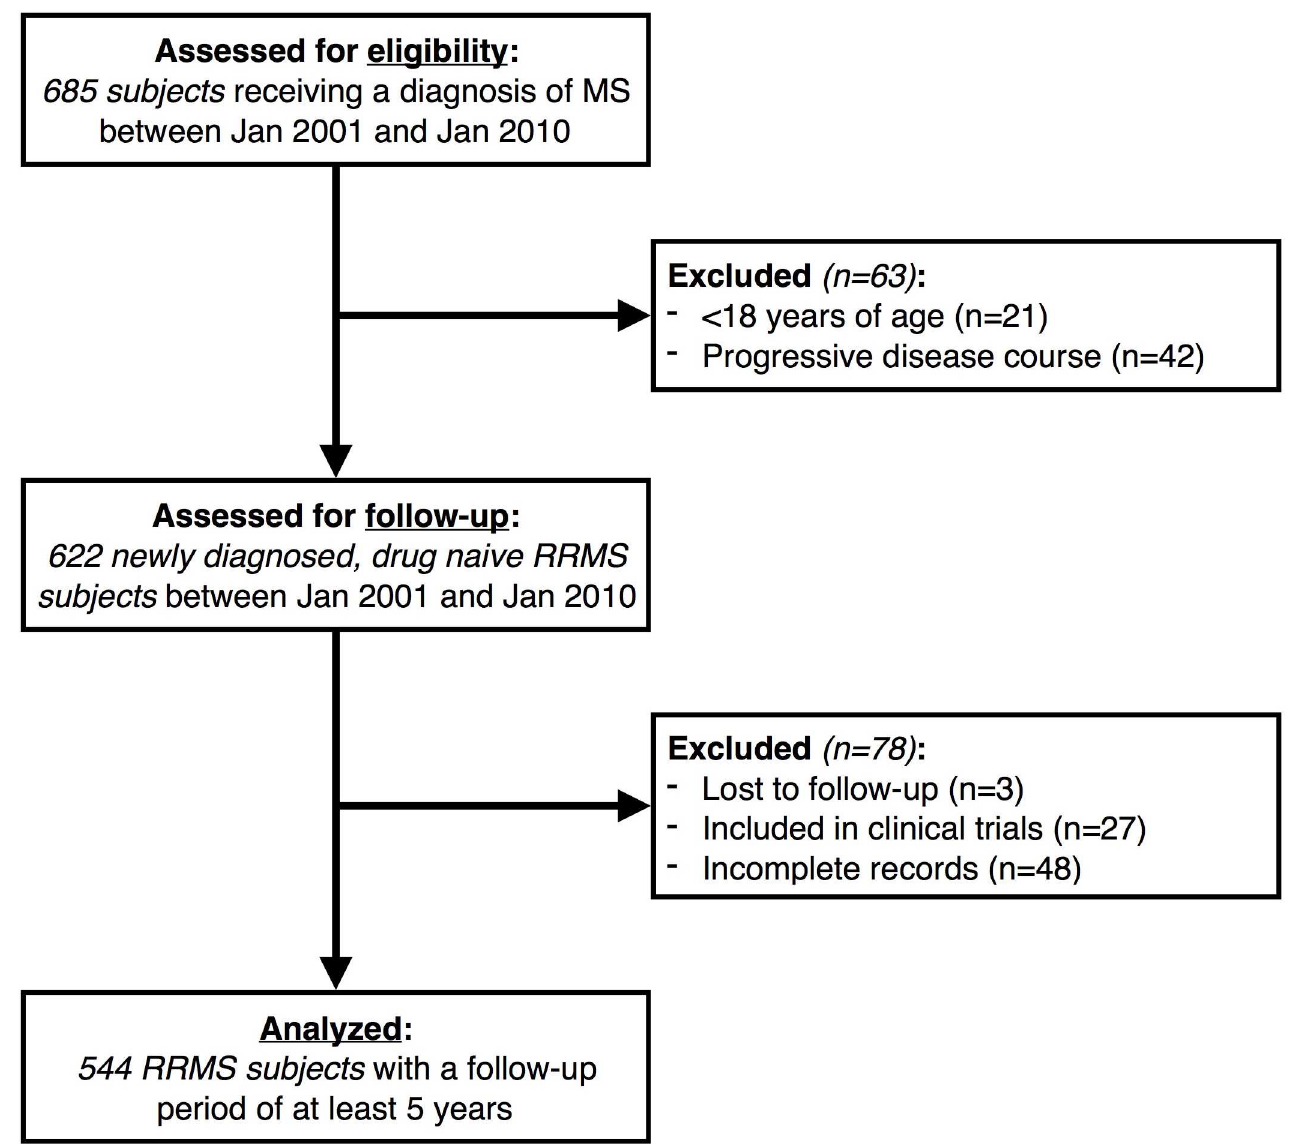
Fig 1. Patient disposition flow diagram. Patient dispositionflow diagram showingpatients included,excludedor lost-to-follow-upwithin the study cohort. MS: Multiple Sclerosis; RRMS: Relapsing-Remitting